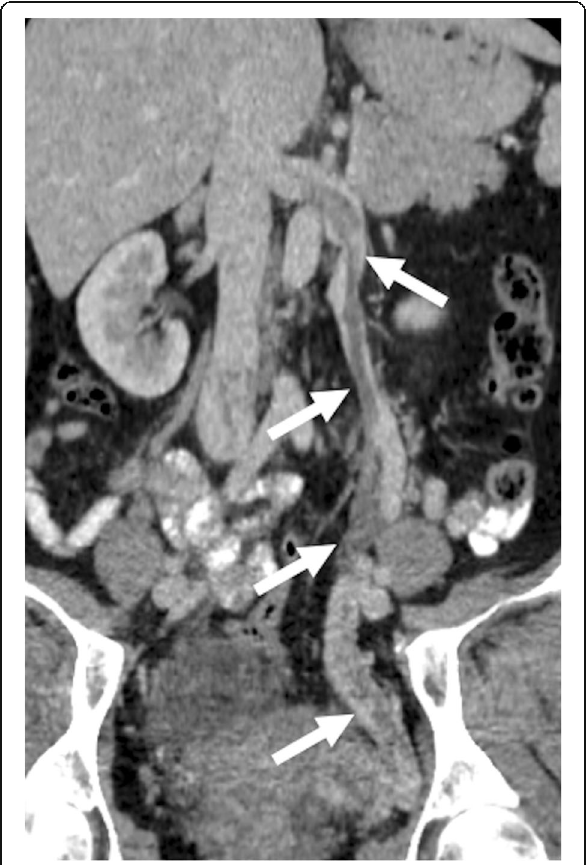
Fig. 20 Ovarian vein thrombosis. A 44-year-old female presented to ED with fever and abdominal pain 13 days after laparoscopic myomectomy. Coronally reformatted post-contrast CT image demonstrates acute thrombus (arrows) within the left gonadal vein with extension into the left renal